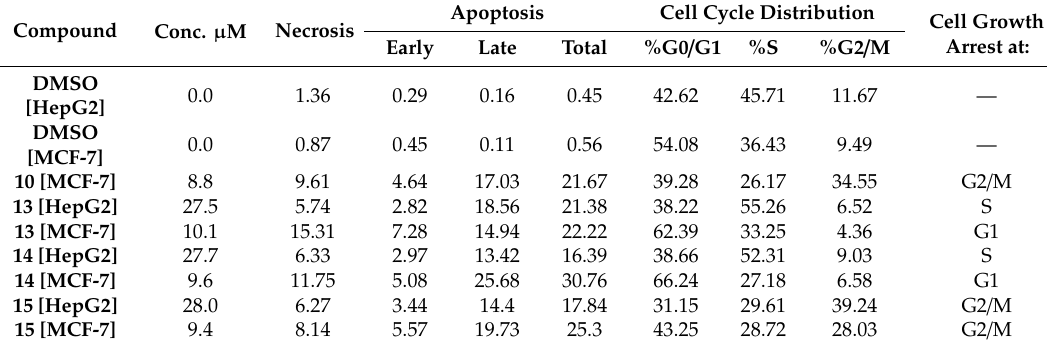
Table 2. Flow cytometry analysis of HepG2 and MCF-7cell cycle and induction of apoptosis